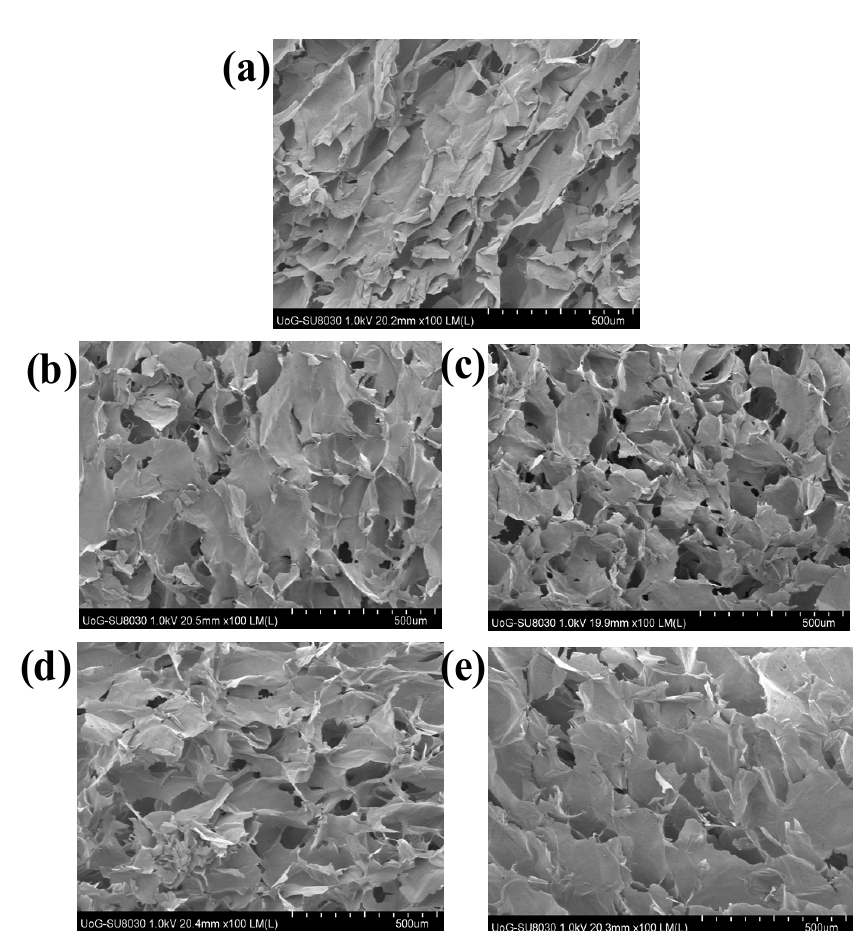
Figure 1. Scanning electron microscopy (SEM) images of ( a ) selected optimized BLK 1.5% CARR:SA (1:3), and their corresponding BSs loaded wafers i.e., ( b ) 0.1% RL ( c ) 0.2% RL ( d ) 0.1% SL ( e ) 5% SL.